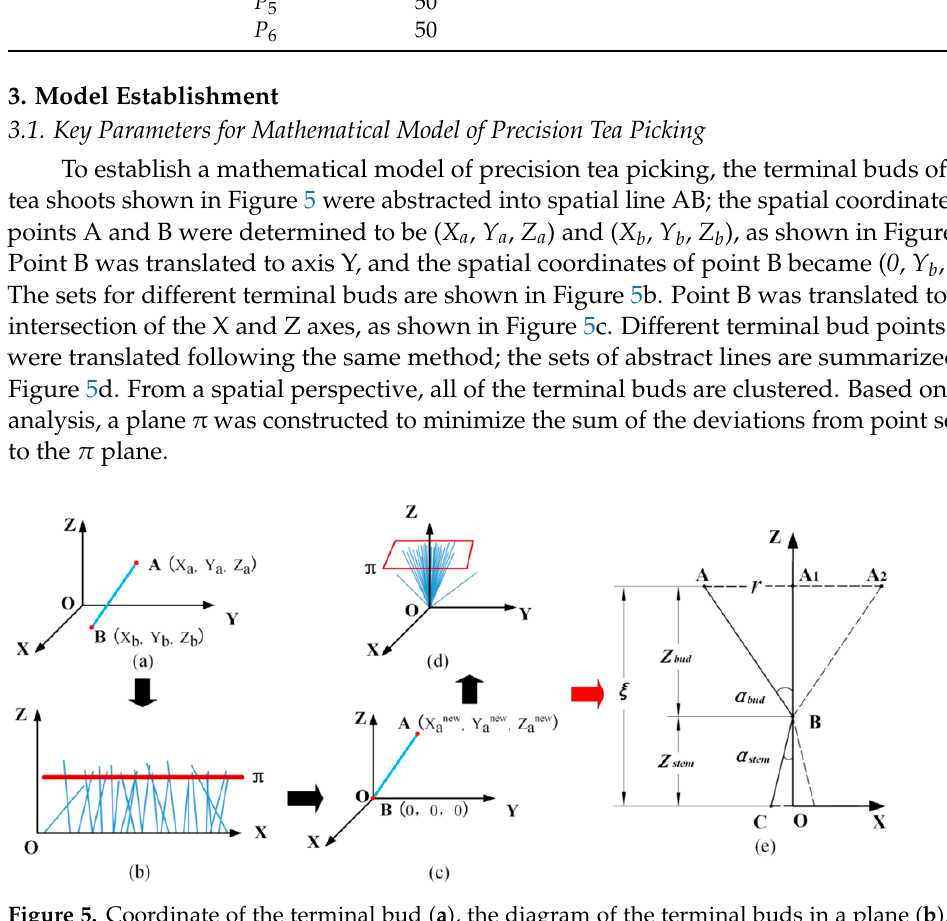
Figure 5. Coordinate of the terminal bud ( a ), the diagram of the terminal buds in a plane ( b ), the plane coordinates of the a single terminal bud after translation ( c ), the plane coordinates of the terminal buds after translation ( d ) and the established tea leaf precise picking model ( e ).